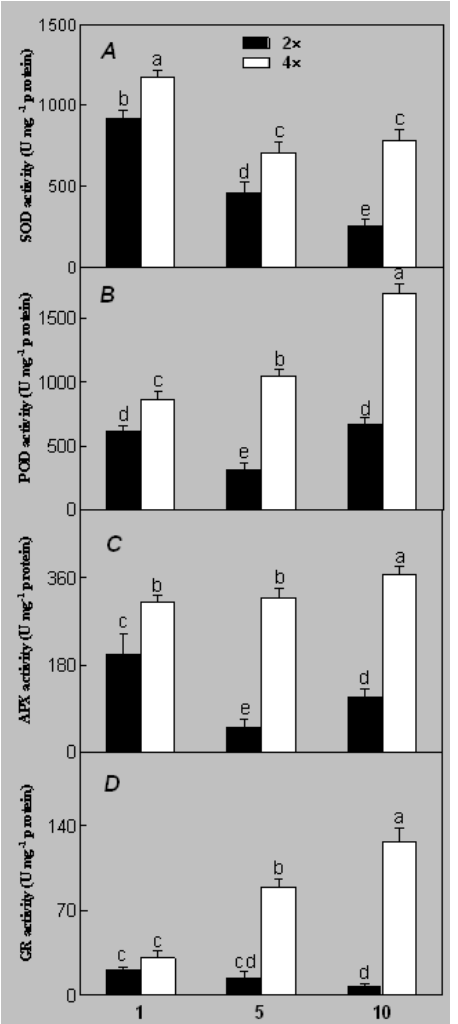
Figure 6. Effects of salt stress on the activities of superoxide dismutase (SOD) ( A ), peroxidase ( POD) ( B ), ascorbate peroxidase (APX) ( C ), and glutathione reductase (GR) ( D ) in the leaves of Robinia pseudoacacia diploid (2×) (black bars) and tetraploid (4×) (white bars) plants growing after salt treatment. Values followed by different letters are significantly different from each other at p < 0 . 05 according to Duncan’s method. Each data point represents the mean ± standard error of three